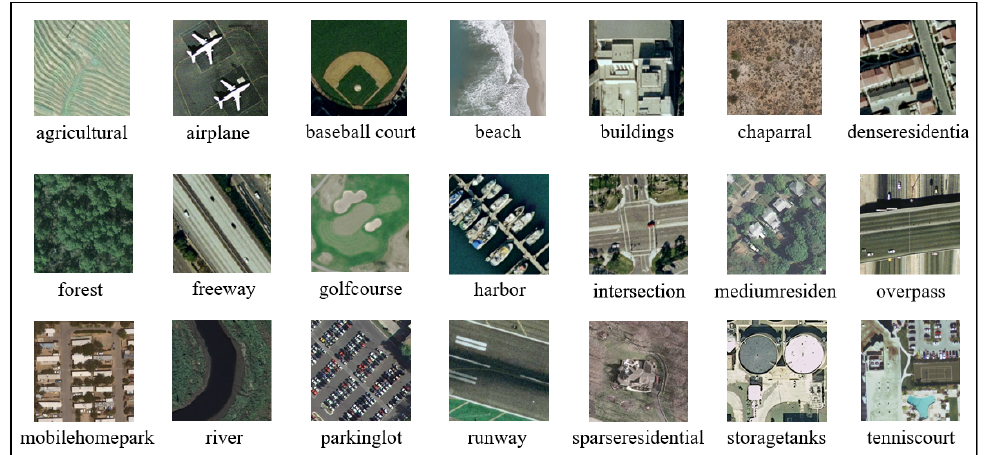
Figure 4. Scene images derived from 21 categories in the UC Merced dataset. The RS images are divided into three parts. Two of these are used for training and validation of the model, while another dataset evaluates the model through cross valida ‐ tion. For the training task, five scene categories were randomly selected from the dataset 𝐷 (cid:3047)(cid:3045)(cid:3028)(cid:3036)(cid:3041) to simulate the few ‐ shot task. Extract one and five samples from each category to form a meta ‐ task. For each test task, five scene categories were also randomly selected in the dataset 𝐷 (cid:3047)(cid:3032)(cid:3046)(cid:3047) , with one and five labeled samples for each scene category. 2.6. Experiment Setups For traditional deep learning, an iteration represents the entire data set propagating forward once through a neural network. For the few ‐ shot learning in this experiment, alt ‐ hough one or several label samples are randomly sampled in each task, all samples are likely to be sampled when the number of tasks is large enough. 8000 training tasks were set in the experiment, the initial value of the learning rate was 0.005, and the initial pa ‐ rameters of the optimizer were set to 0.5. In addition, the generalization of all models is evaluated by cross ‐ entropy loss. All experiments were set to five scene categories, with one sample and five samples selected for each scene category. Theoretically, the more samples of the scene, the higher the accuracy of the experiment. In order to avoid the model’s preference for specific data, all experiments were randomly sampled from 𝐷 (cid:3047)(cid:3032)(cid:3046)(cid:3047) for 15 tests. For the test results, 600 few ‐ shot tasks were sampled to test the model, and the test results were averaged to obtain the final result. The accuracy assessment metrics of our experiment is usually N ‐ way K ‐ shot. N cat ‐ egories are selected, and K samples are selected for each category. Generally, 𝑁 ∈ (cid:4668) 5,10,15,20 (cid:4669) , 𝐾 ∈ (cid:4668) 1,5 (cid:4669) . In the model training phase, the training model is constructed and trained on the selected 𝑁 (cid:3400) 𝐾 samples. In the test phase, K samples from N categories are selected to perform the N ‐ way K ‐ shot classification task. According to the prediction re ‐ sults, the prediction category is determined, and the accuracy rate of the prediction cate ‐ gory consistent with the actual category is the accuracy assessment metrics. 3. Results 3.1. Experiment on UC Merced Dataset In the few ‐ sample RS scenario, the proposed model (MLLD) performs well on the relatively complex public dataset at UC Merced. Table 2 shows the final comparison re ‐ sults, where the classification result is obtained by testing ten rounds. The test results are the average of 600 few ‐ shot tasks on the new set. The other eight representative methods were compared under the 5 ‐ way 1 ‐ shot and 5 ‐ way 5 ‐ shot. Eight scene classification